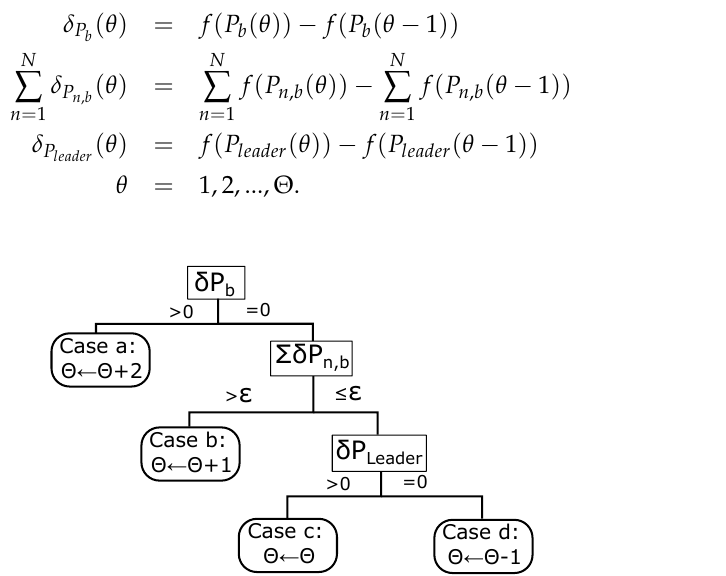
Figure 3. Flow diagram of the lifespan control based on the behavior of the global best, swarm and